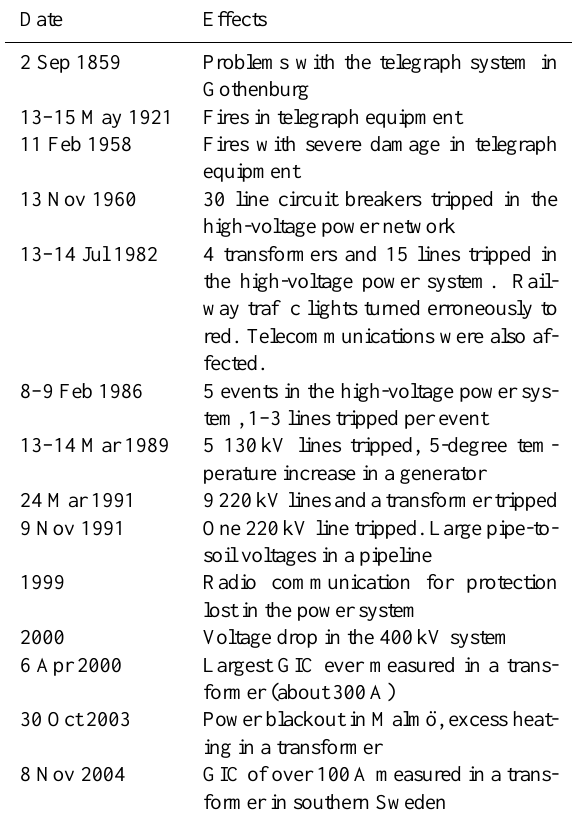
Table 1. Problems due to GIC in ground-based technological sys- tems in